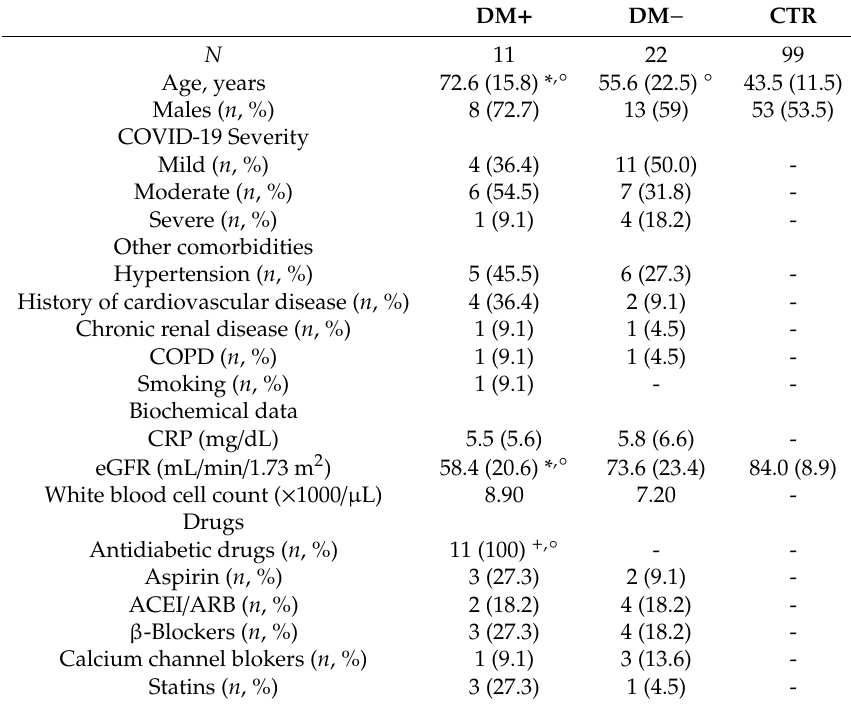
Table 1. Patient’s